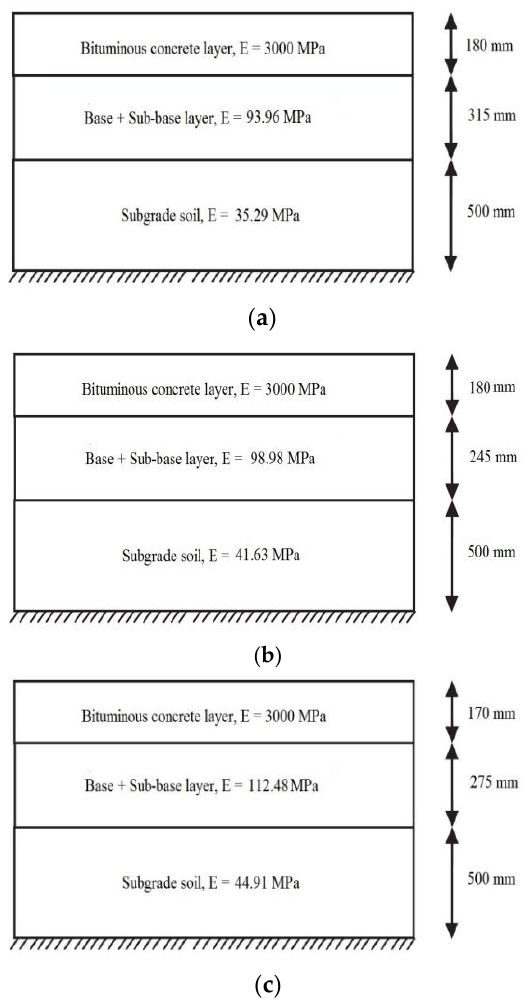
Figure 11. Contour plot of 5% CBR. ( a ) Horizontal strains, 10 MSA; ( b ) vertical strains, 10 MSA.